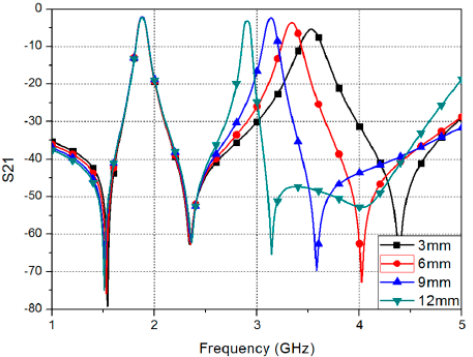
Figure 9. Transmission coefficient of the proposed filter for different stub length Ls [29].